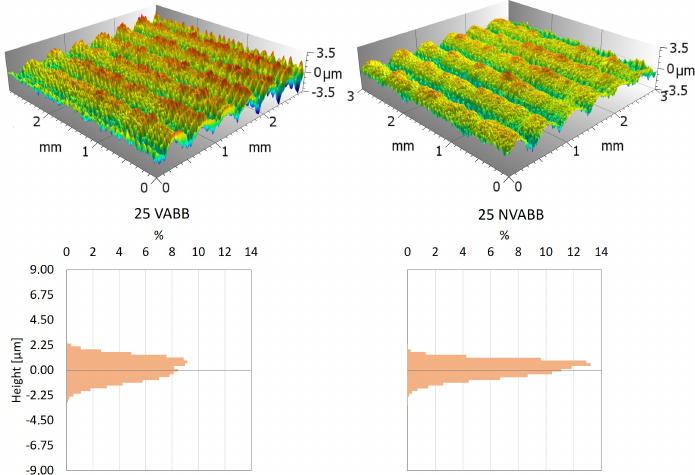
Figure 10. 3D views and height histograms of surfaces processed with 450 N and three passes. ( Left ) VABB. ( Right )